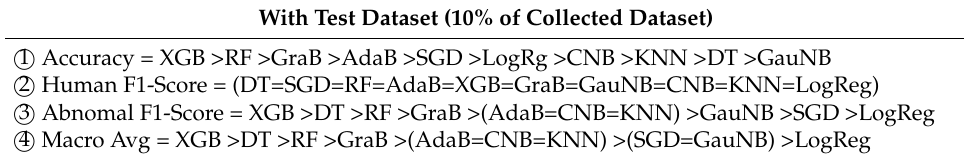
Table 9. Result for the test